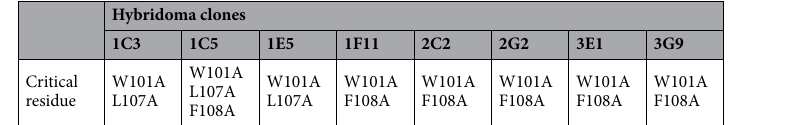
Table 3. Critical mutations that abolished HuMAb